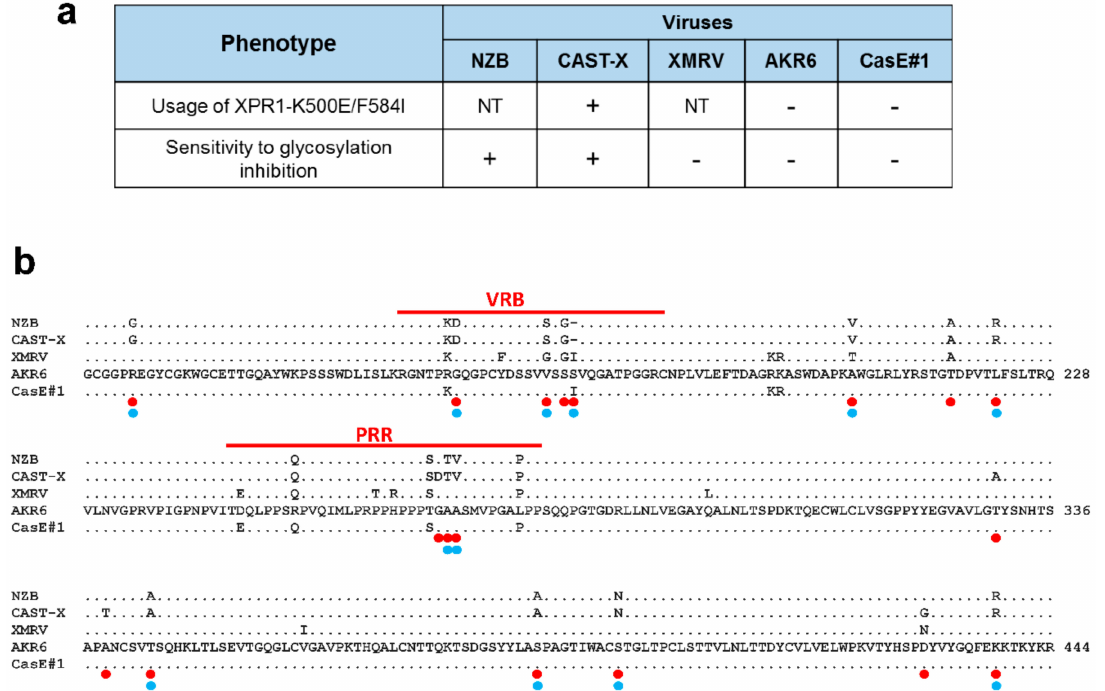
Figure 5. Multiple replacement mutations alter the C-terminal end of the AKR6 SU Env. ( a ) AKR6 host range differs from other X-MLVs [35,45,46]. ( b ) Alignment of the amino acid sequences in the replaced segment of the AKR6 Env compared to X-MLVs with shared or different host range properties. Red lines indicate the variable VRB and PRR domains. Red dots mark sites that distinguish viruses able to use a mutant XPR1 receptor and blue dots mark viruses that differ in their sensitivity to glycosylation